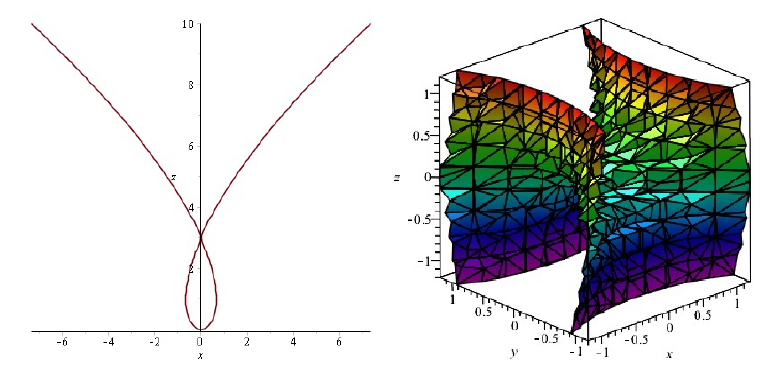
Figure 1. left : algebraic curve γ 1 ( u ) ; right : algebraic surface E 1 ( x , y , z ) =